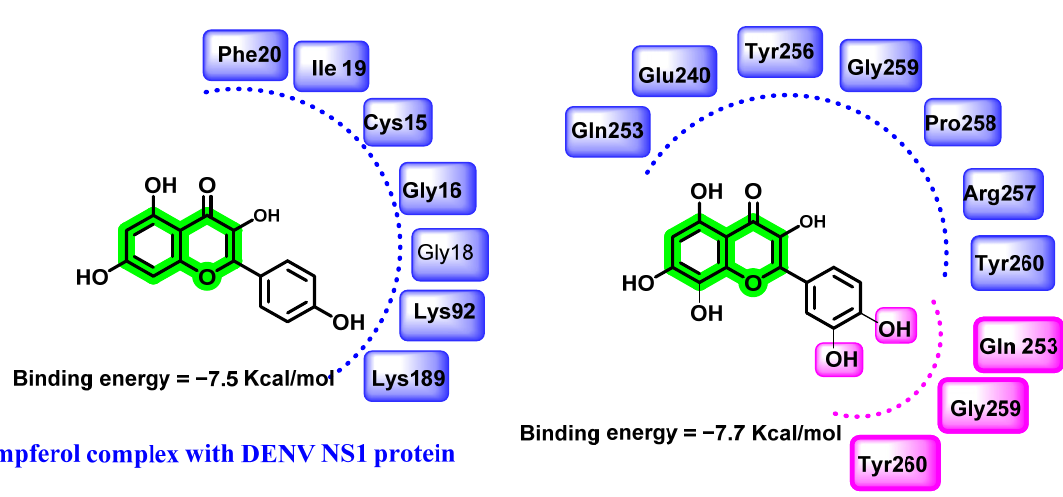
Figure 4. Hydrogen bonding (pink) and hydrophobic interactions (blue) of kaempferoland gossypetin with DENV NS1protein.